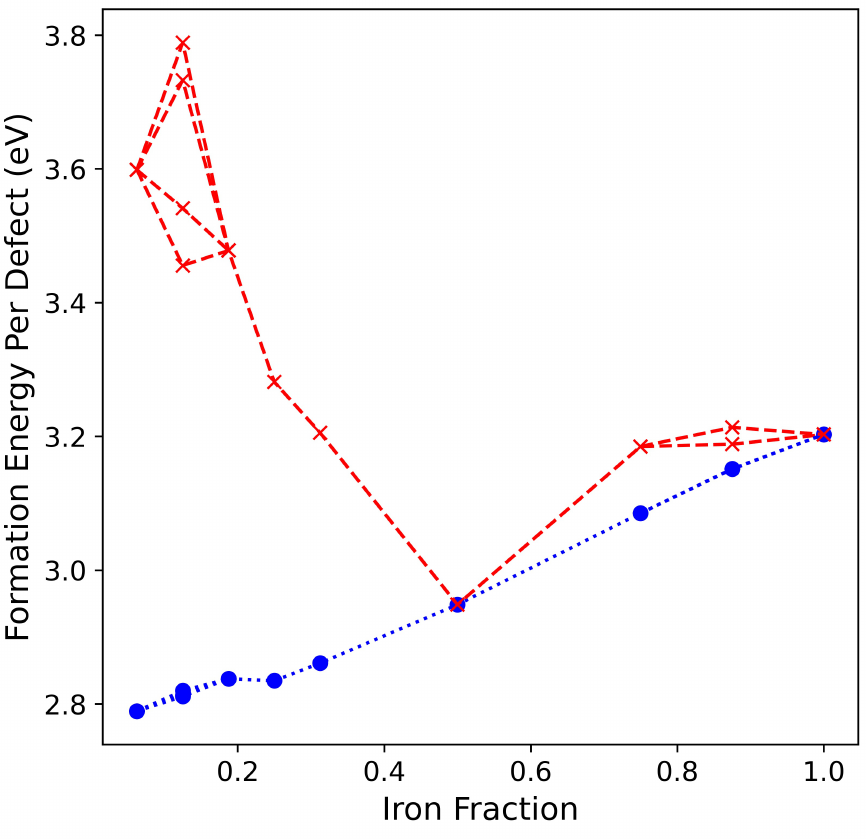
Figure 6. Defect formation energies (per-defect) for [ Fe Al ] 0 antisites (blue circles) and [ Fe Cu ] 2 + + [ Cu Al ] 2 − defect complexes (red crosses). The multiple values at p = 0.125 and p = 0.875 correspond to the α 2.1 , α 2.2 , α 2.3 , β 2.1 , β 2.2 , β 2.3 and β 2.4 configurations and their inverted systems,